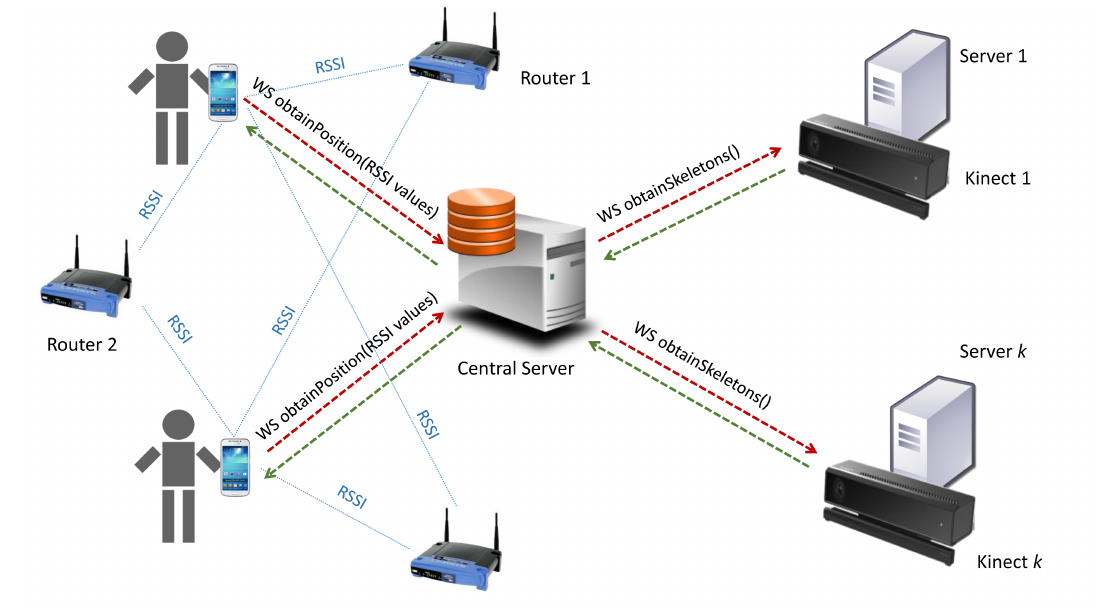
Figure 4. Scheme of web service